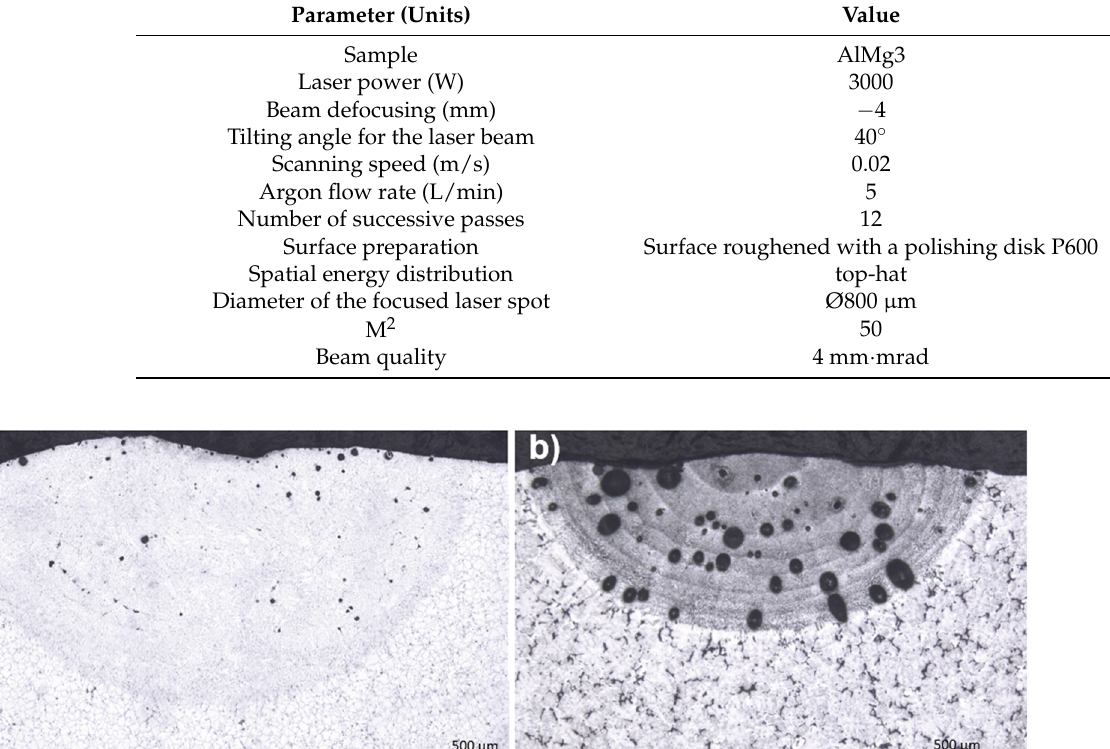
Table 1. Optimum operating conditions for AlMg3 alloy laser welding using our experimental set-up.